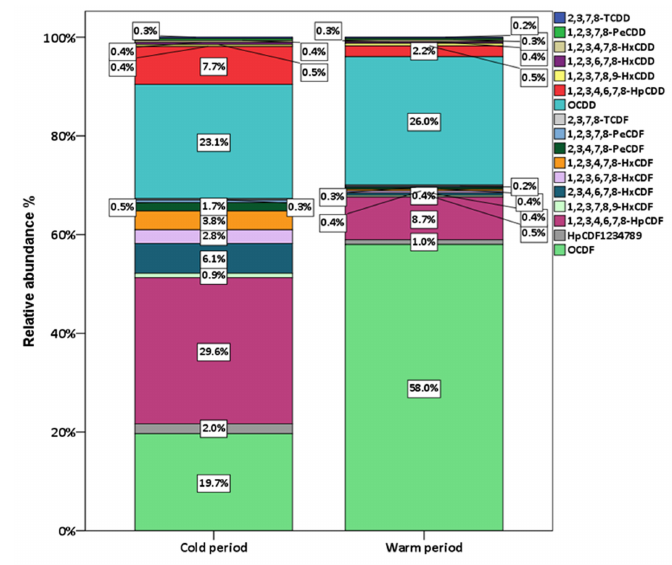
Figure 7. Relative abundance among PCDD / F congeners for the cold and warm periods.